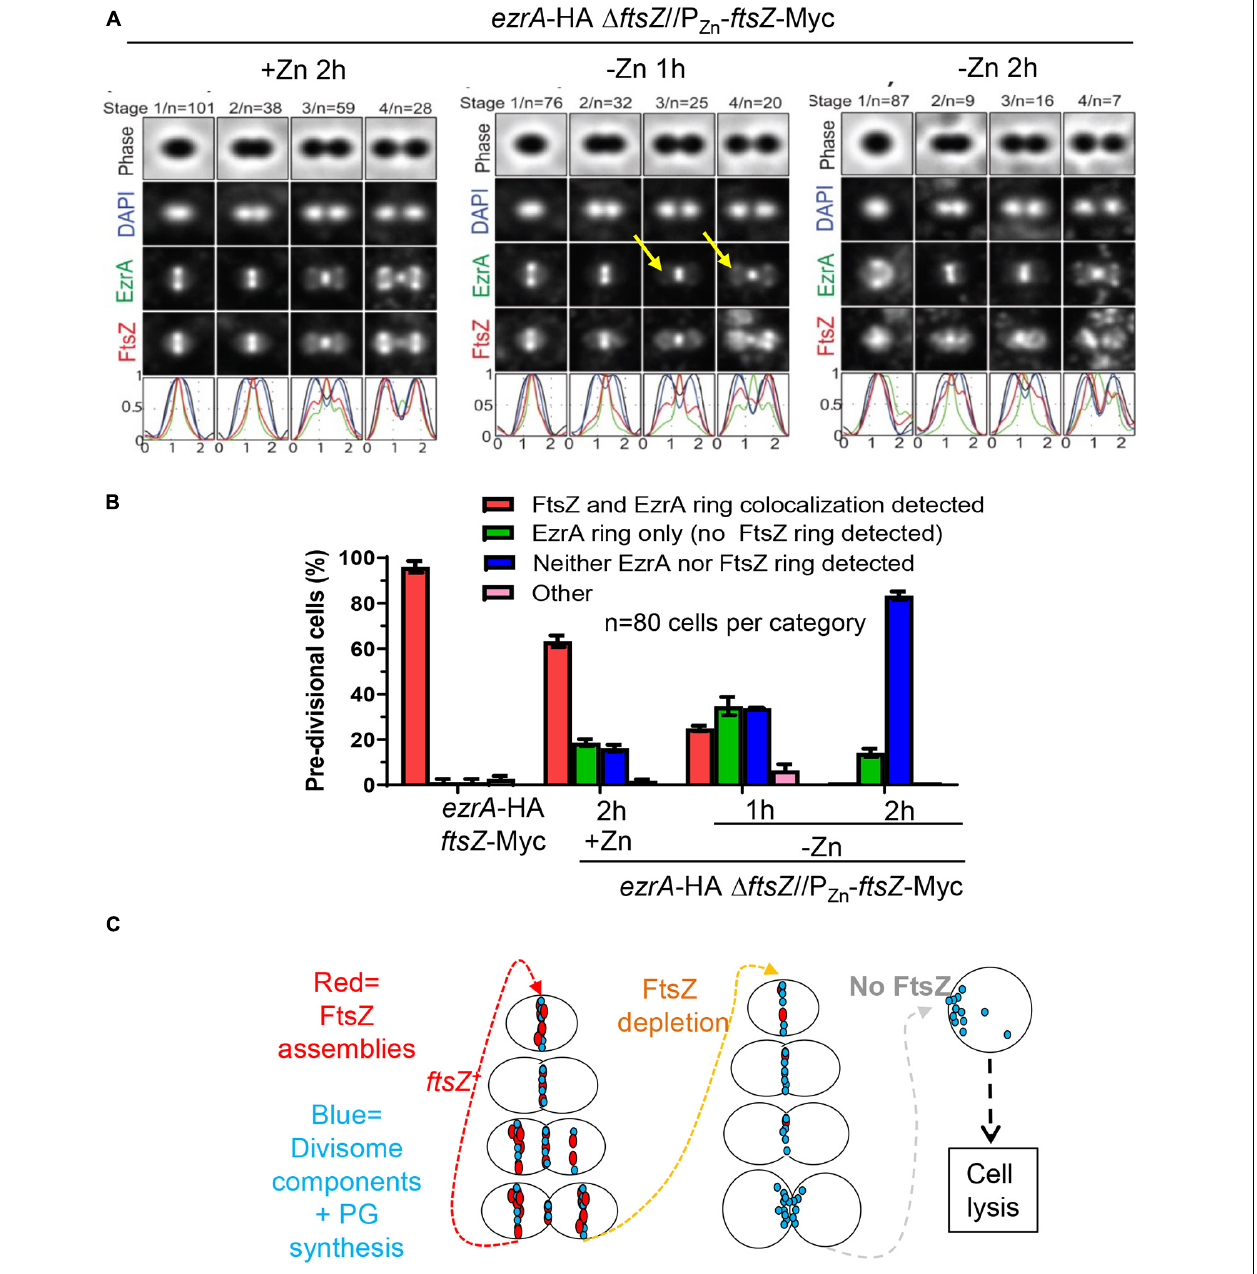
FIGURE 8 | Recruitment of EzrA-rings to equators of future dividing cells is dependent on FtsZ. Wild-type parent strain IU7223 ( ftsZ -Myc ezrA -HA) and FtsZ depletion strain IU8237 ( ezrA- HA (cid:49) ftsZ // bgaA ::P Zn - ftsZ -Myc) were grown exponentially, and IU8237 was depleted of FtsZ-Myc by shifting cells to BHI broth not supplemented with additional ZnCl 2 and MnSO 4 as described in section “Materials and Methods.” Cells were obtained at appropriate time intervals and prepared for IFM as described in Materials and Methods. Data are from two independent biological replicates. (A) Averaged images with fluorescence intensity traces showing FtsZ-Myc and EzrA-HA localization during FtsZ-Myc depletion in IU8237 ( ezrA -HA (cid:49) ftsZ //P Zn - ftsZ -Myc). Cells were binned into division stages 1-4, and images from the indicated number of cells ( n ) from at least two independent biological replicates were averaged using IMA-GUI program as described in section “Materials and Methods.” (i) Row 1, cell shapes determined from phase-contrast images; row 2, nucleoid locations from DAPI labeling; row 3, EzrA-HA locations from IFM; row 4, FtsZ-Myc locations from IFM; row 5, normalized mean fluorescence intensity distributions along the horizontal cell axis for each channel (black, phase image; blue, DNA; green, EzrA; red, FtsZ). Arrows indicate equatorial ring where EzrA is recruited in +Zn condition but less in -Zn conditions. (B) Bar graph quantifying FtsZ-Myc and EzrA-HA-ring co-occurrence during FtsZ-Myc depletion. Bars are the averages of two separate biological replicates while error bars are the SD. (C) Schematic for the orchestration of divisome components (turquoise) by FtsZ (red). FtsZ is required to assemble division sites. In the absence of FtsZ, pre-formed divisome rings can still exist but recruitment of the divisome to equators of future dividing daughter cells ceases to exist. Diffuse unorganized PG synthesis at old division sites still occurs, which leads to enlargement of cells, cell death, and eventual cell